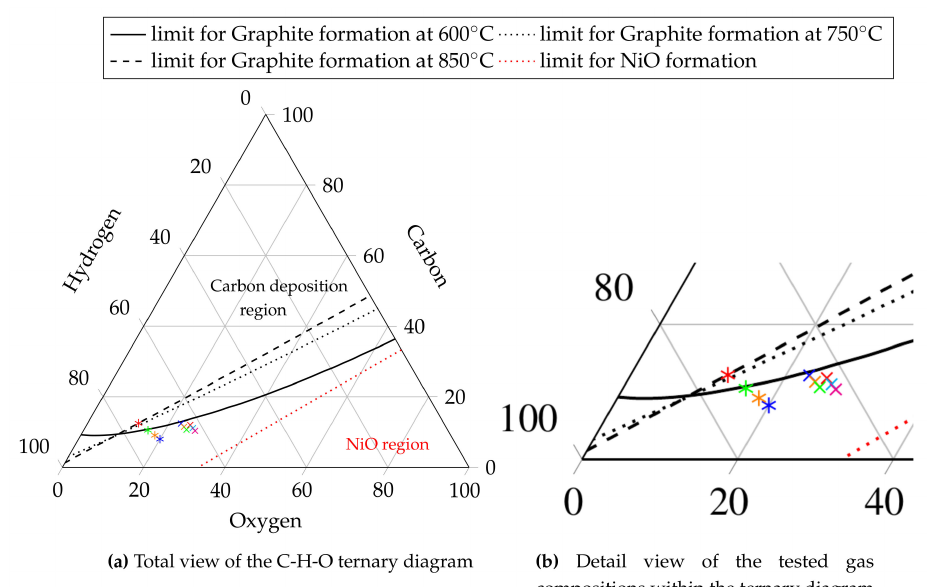
Figure 4. C-H-O ternary diagram; Operating point - gas composition